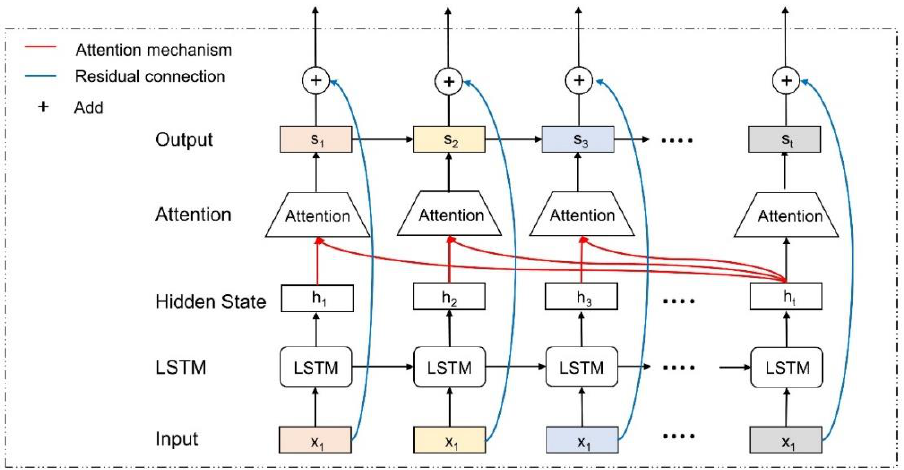
Figure 2. One layer AR-LSTM.